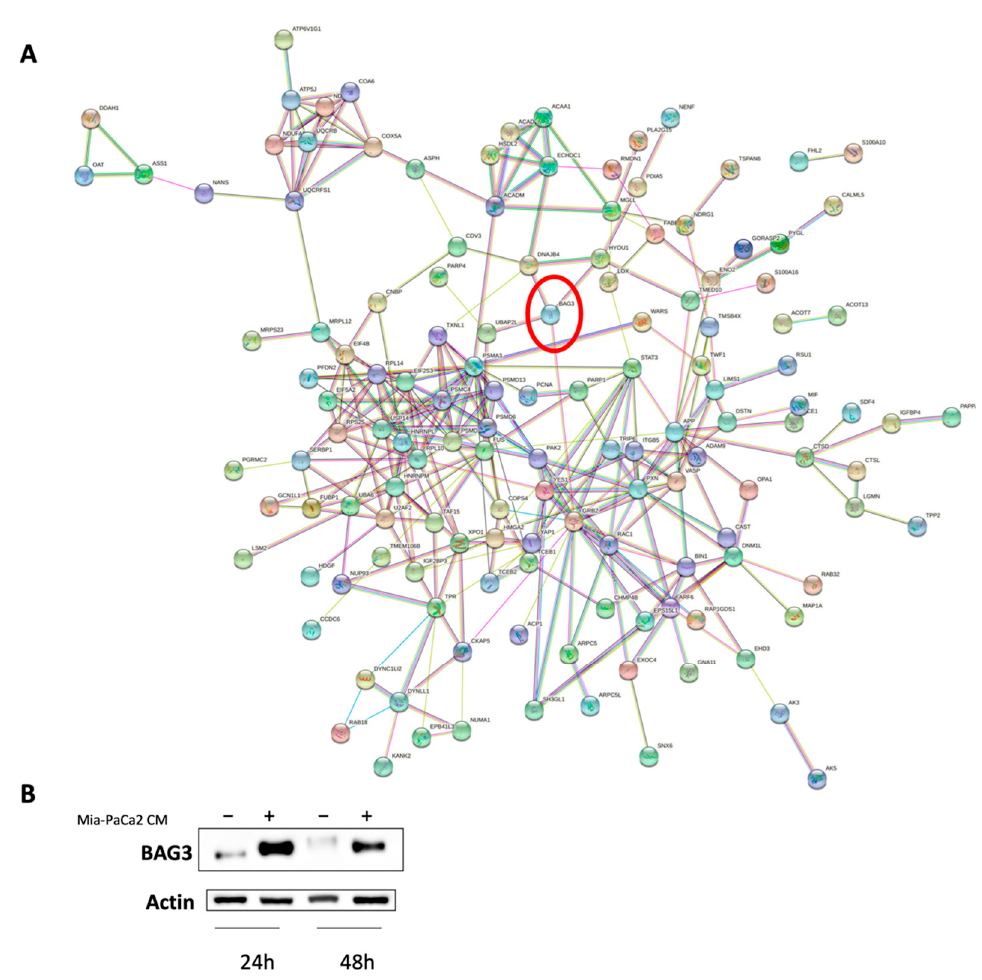
Figure 6. BAG3 is strongly induced in HDF cells treated with MIA-PaCa-2 CM. ( A ) PPI network predicted by STRING among the proteins identified in lysate of HDF cells treated for 48 h with CM. BAG3 is highlighted by a red circle. ( B ) Western blot of BAG3 in HDF cell lysate treated for 24 h and 48 h with MIA-PaCa-2 CM.